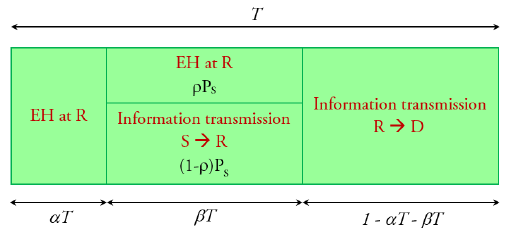
Fig. 2: General hybrid TSR-PSR relaying